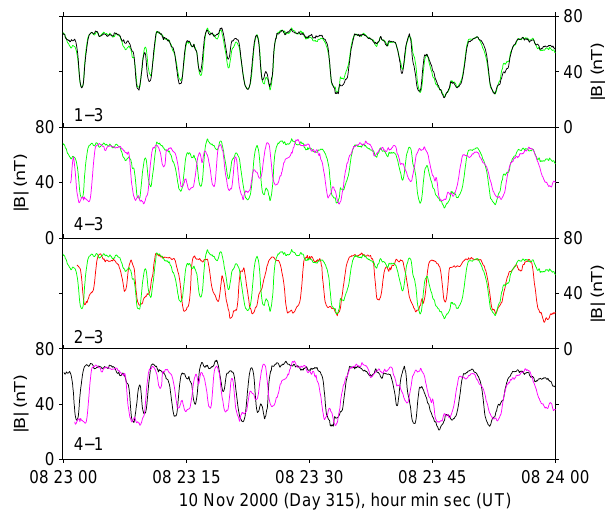
Fig. 5. A comparison of the magnetic field magnitude seen at dif- ferent spacecraft pairs. The panels show Cluster 1 (black) and 3 (green), Cluster 4 (magenta) and 3 (green), Cluster 2 (red) and 3 (green) and finally Cluster 1 (black) and 4 (magenta).